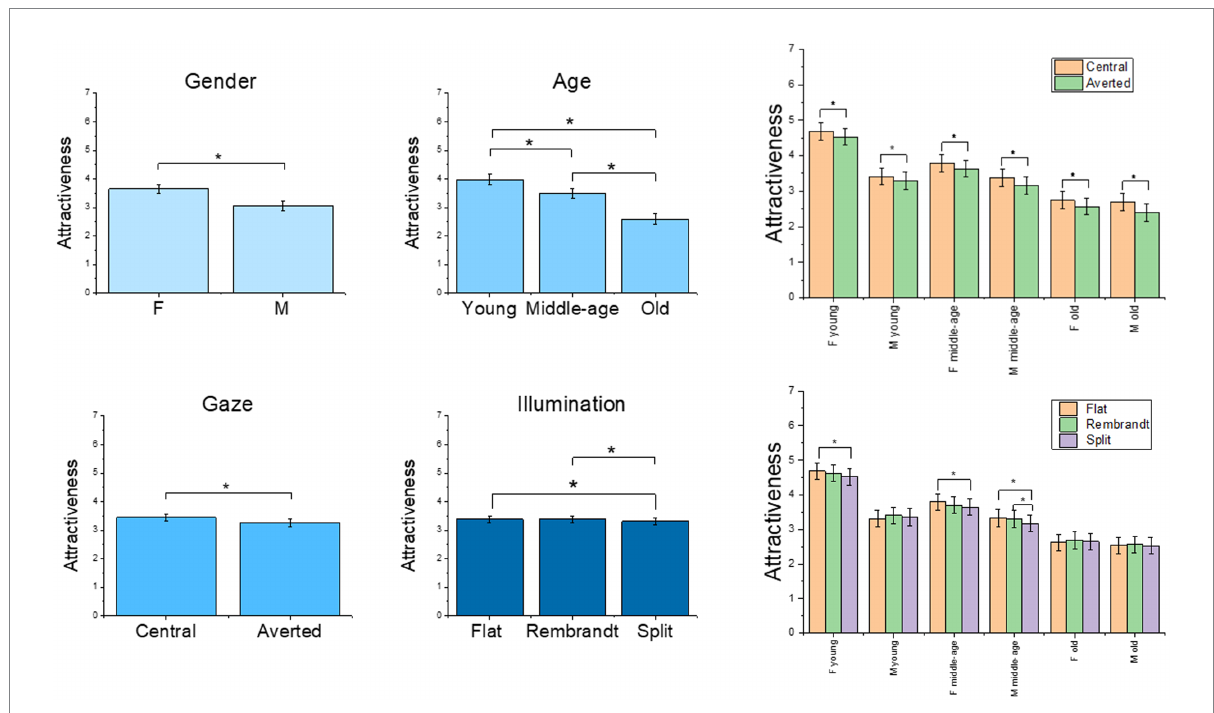
FIGURE 2 Plot of the estimated mean scores from the attractiveness rating, depicting significant main effects and higher order interactions. The asterisks highlight significant main effects and significant results from the post hoc analyses. C = central gaze, A = averted gaze, F = female models, M = male models. Error bars represent mean standard